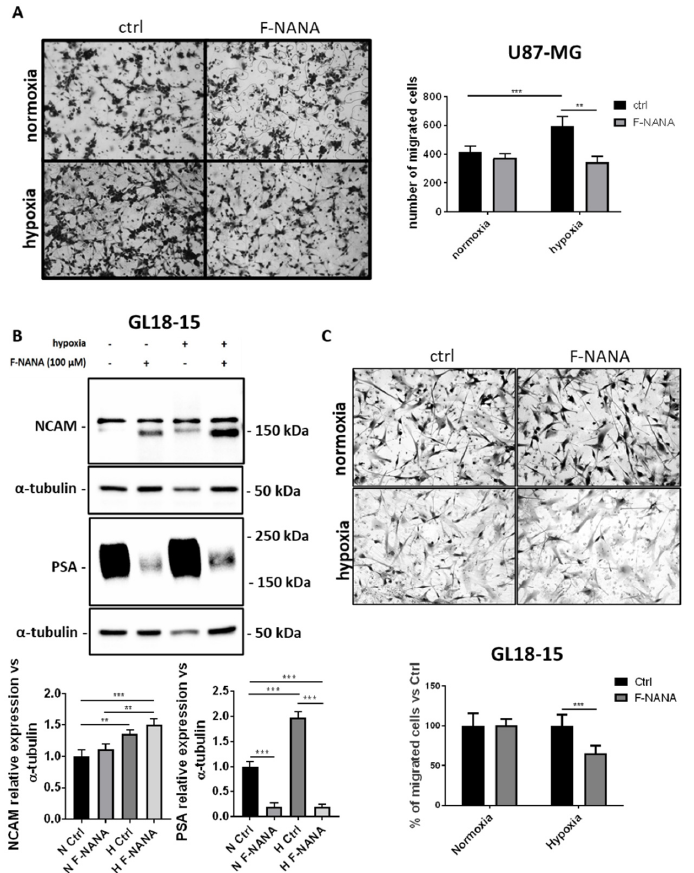
Figure 4. Effect of PSA inhibition on the migration of GBM cells under hypoxic conditions. ( A ) Transwell migration assay showing the number of migrated U87-MG cells under normal and low oxygen concentration, in presence or not of 100 μ M F-NANA. ( B ) Western blot analysis showing the expression of NCAM and PSA in a patient-derived GBM primary culture (GL18-15) exposed to 72 h chronic hypoxia, in presence or not of 100 μ M F-NANA. ( C ) Transwell migration assay showing the percentage versus control of migrated GL18-15 cells under normal and low oxygen concentration, in presence or not of 100 µ M F-NANA. Results are presented as the mean ± SD of three independent experiments. **: p < 0.01; ***: p <